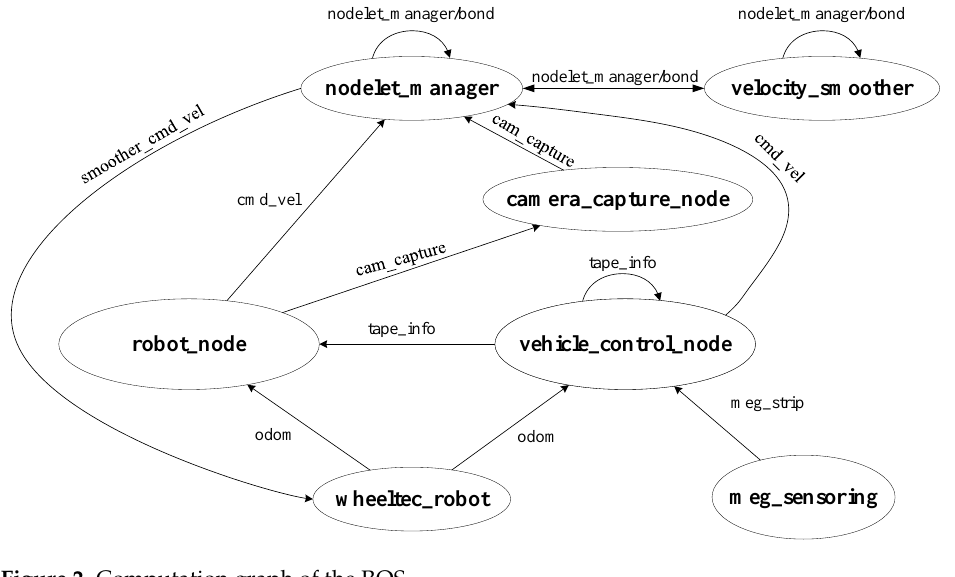
Figure 2. Computation graph of the ROS. Table 2. Interpretation of nodes and topics.